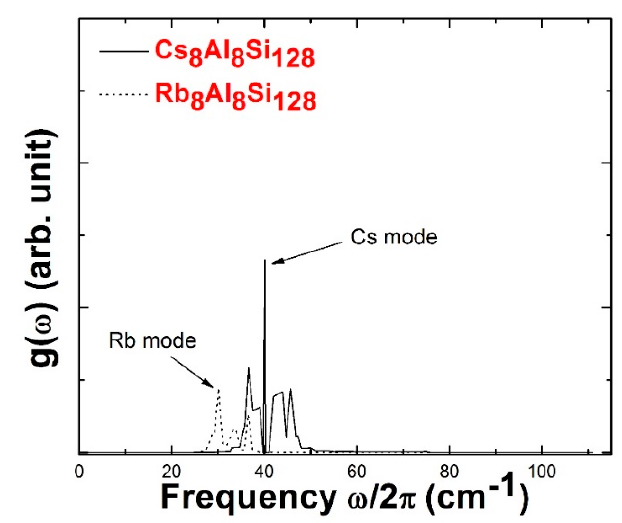
Figure 2. Calculated vibrational density of states (VDOS) vs. frequency for Cs 8 Al 8 Si 128 (solid line) and Rb 8 Al 8 Si 128 (dotted line).